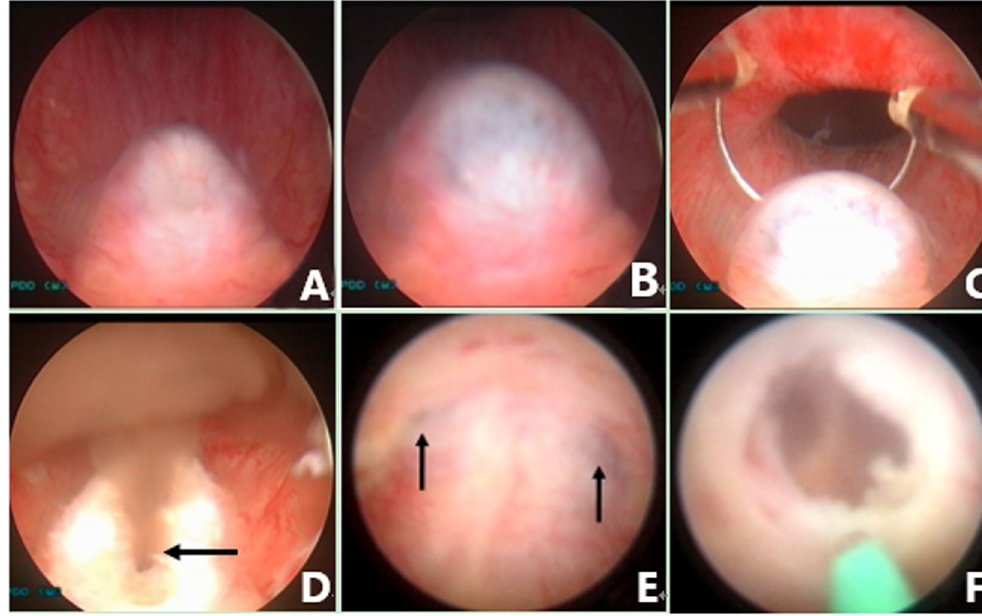
Figure 10. Seminal vesiculoscopy and treatment based on TURED. ( A ) Nothing came from either the ED orifice or the orifice of the PU upon bilateral SV massage, indicating the patients had complete EDO. ( B ) Transrectal massage to the medial area of the prostate showed that the PU opening is obstructed, and the verumontanum presented as a cystic mass with fluctuation. ( C ) Transurethral deroofing resection of the verumontanum was performed. ( D ) After transurethral deroofed resection of the verumontanum, chocolate- like fluid was observed emerging from the orifice of the PU. ( E ) Translucent membranous weak areas were identified at the 4 and 8 o’clock positions on the posterolateral wall of the utricle. ( F ) A holmium laser was used for